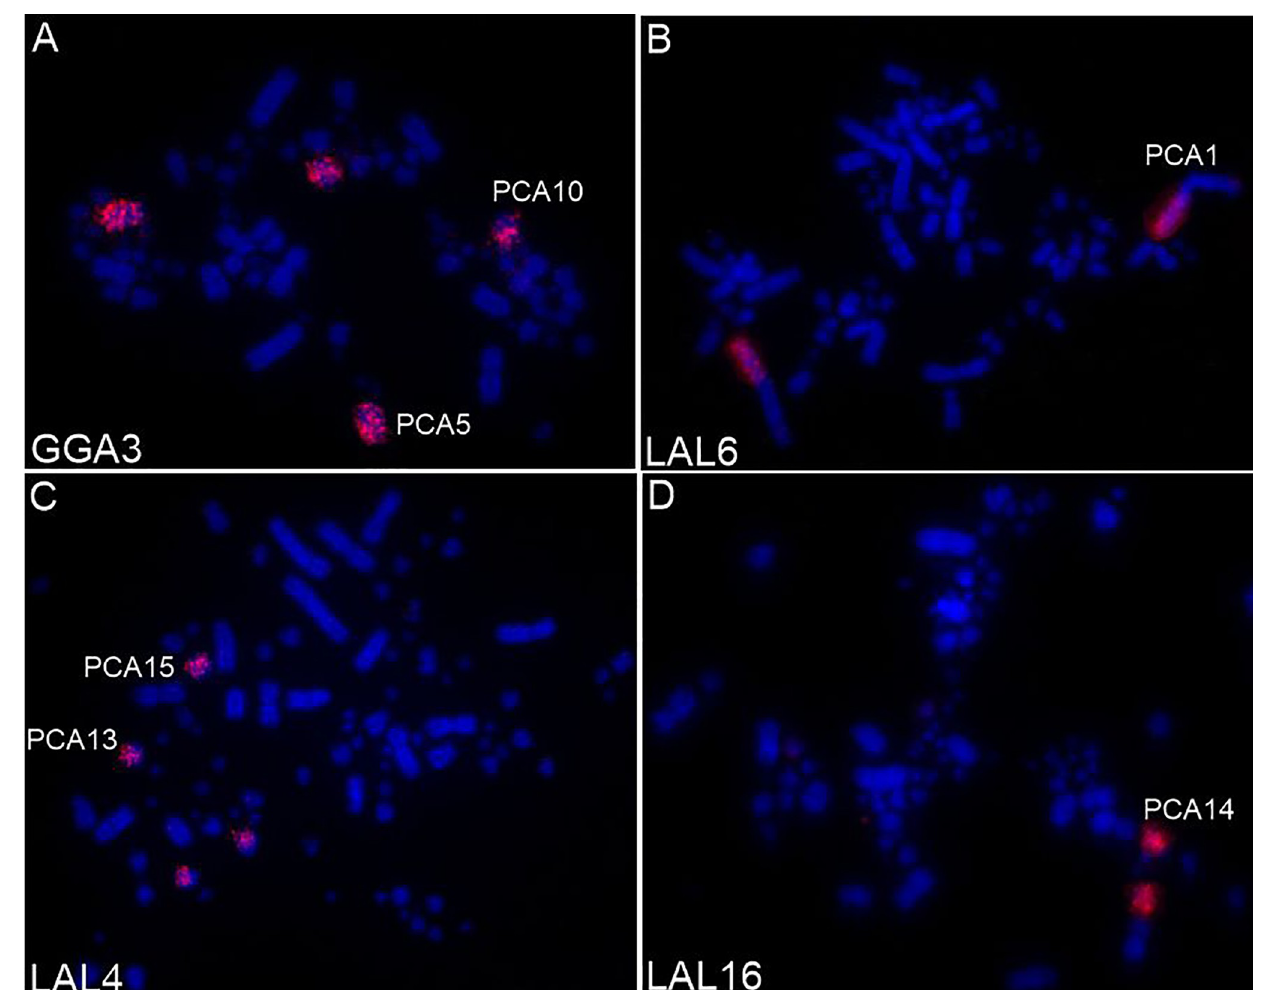
Fig 4. Examples of fluorescence in situ hybridization experiments with whole-chromosome probe derived from G . gallus (GGA) and L . albicollis (LAL) onto P . cayana (PCA)